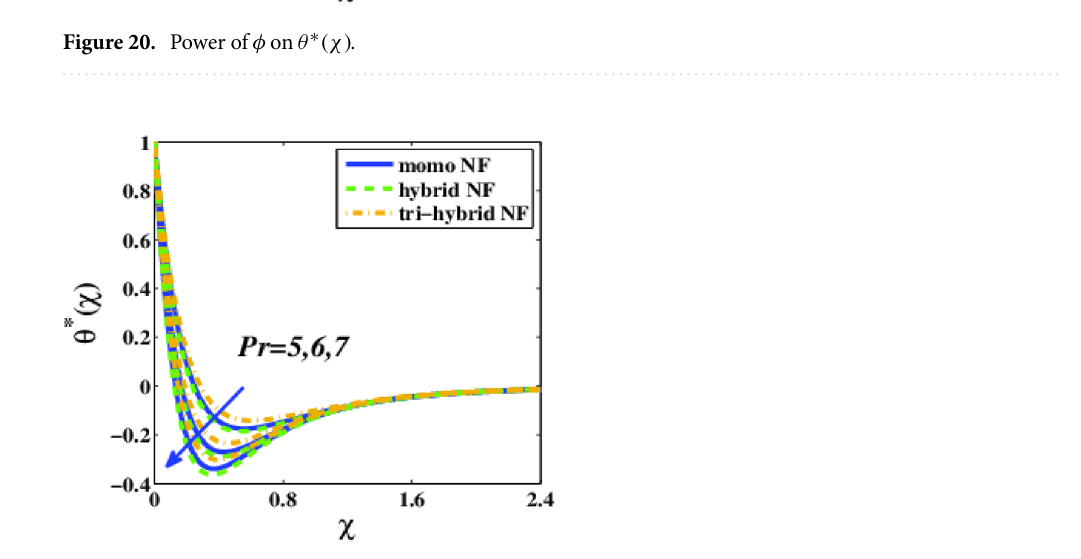
Figure 21. Control of Pr on θ ∗ (χ) .